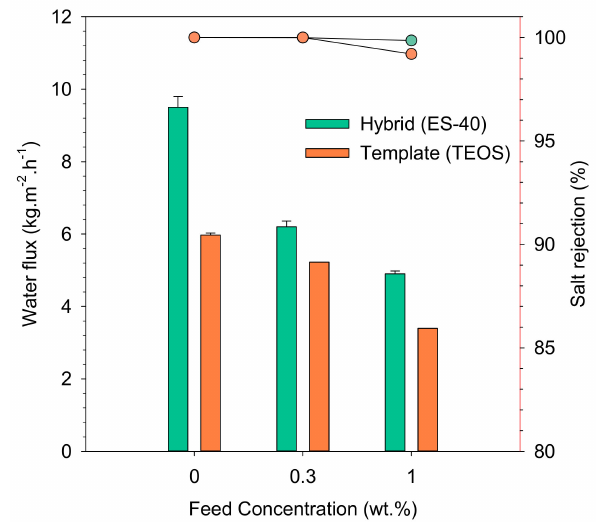
Figure 5. Pervaporation fluxes and salt rejections of hybrid (ES40) and templated (TEOS) membranes for brackish water